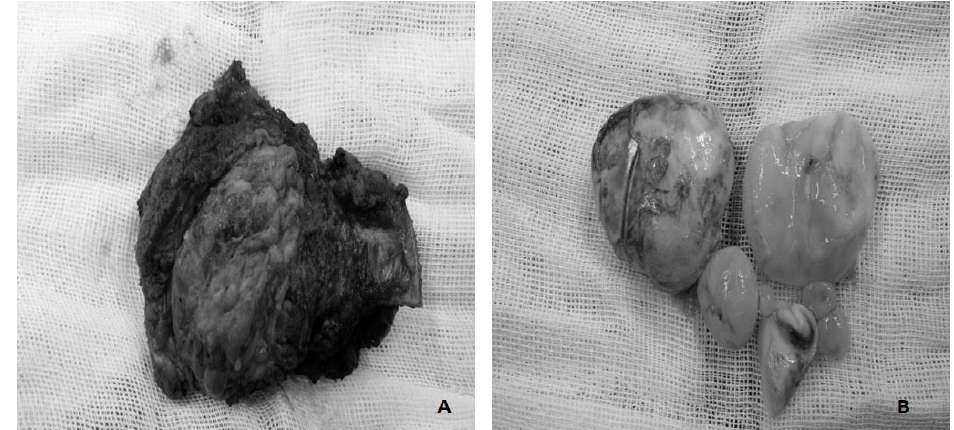
Figure 2. Resected specimen (A) and hydatid cyst of the chest wall